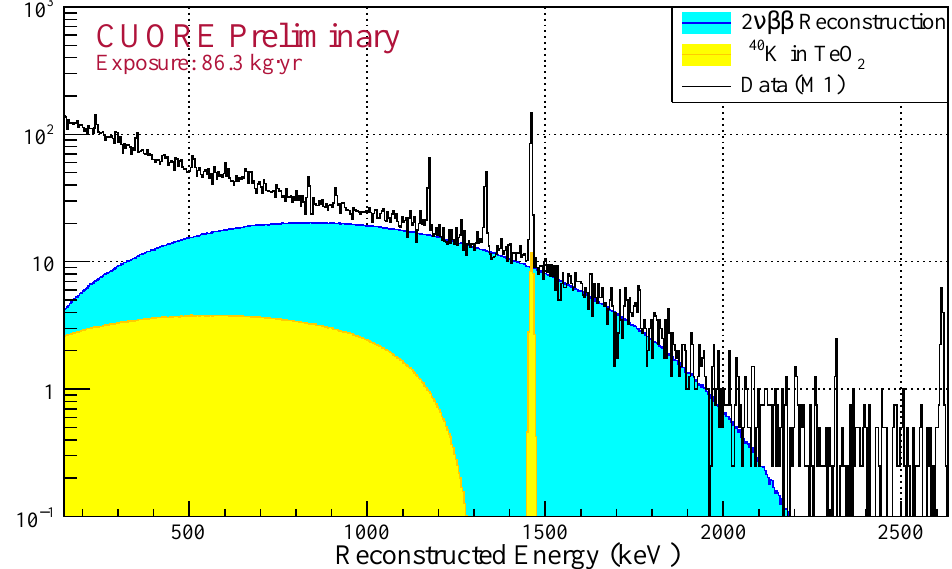
Figure 5. The observed M1L0 spectrum with the superposition of the 2 νββ component (cyan) and 40 K (green). The 2 νββ spectrum dominates the spectrum between 1 MeV and 2 MeV. Note: the binning has been changed for illustrative purpose, the actual fit has been performed with the binning used in Figure 4. Picture from